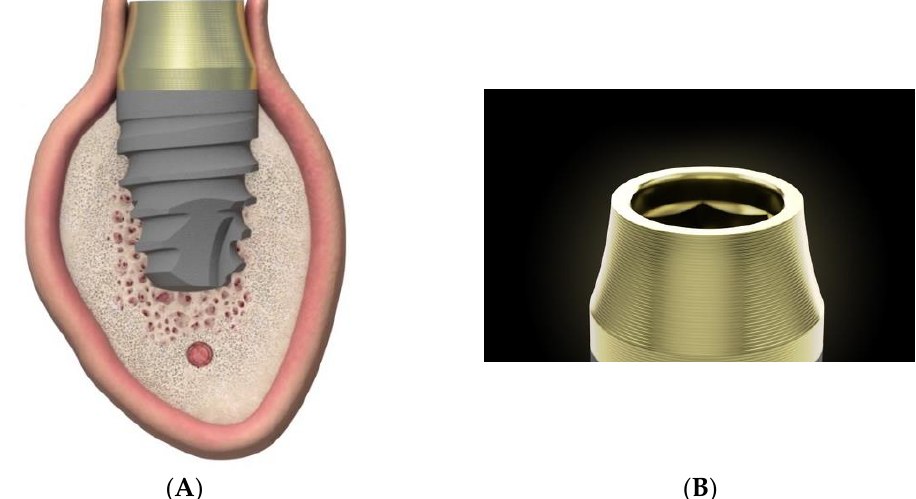
Figure 2. ( A ) lateral image of the design of the PRAMA implant in relation to the peri-implant tissues. ( B ) morphology of the neck of the PAMA implant.